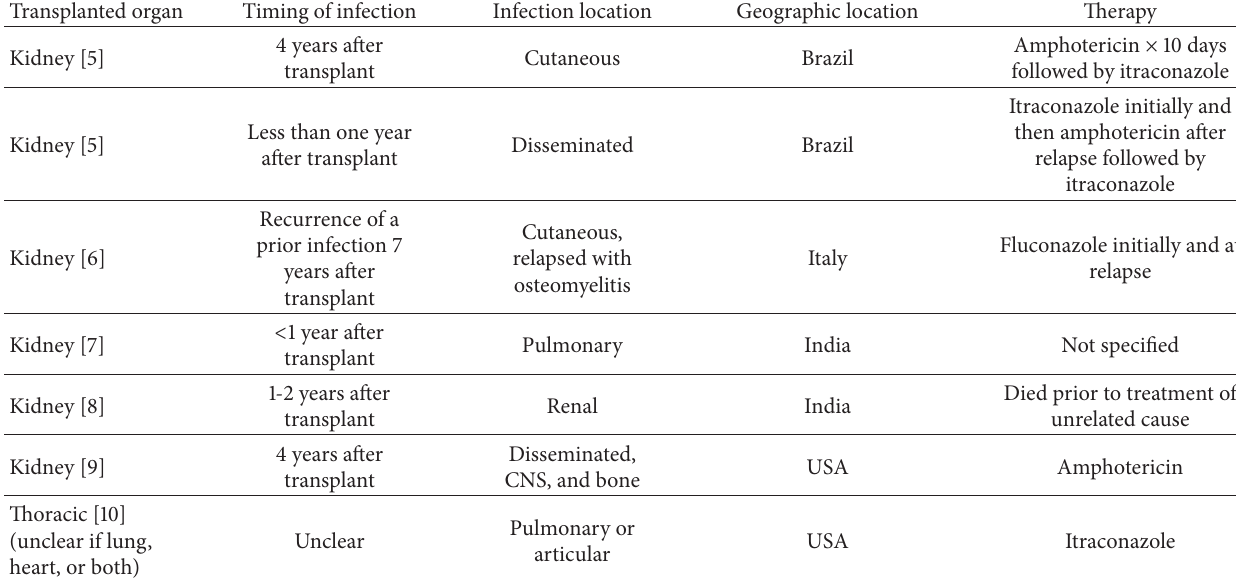
Table 1: Description of reported cases of Sporothrix schenckii infection in solid organ transplant recipients. Transplanted